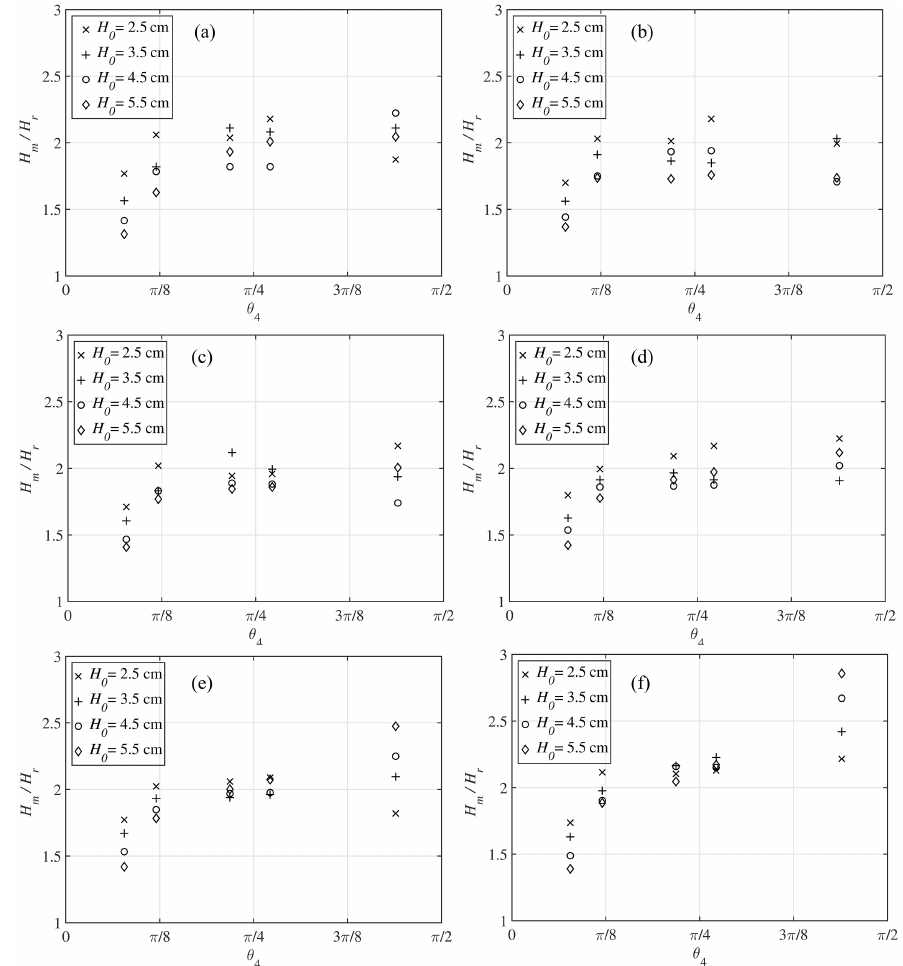
Figure 6. Wave amplification factors, H m /H r , of different cliffs: (a) x = 0.0m, (b) x = 0.06m, (c) x = 0.11m, (d) x = 0.13m, (e) x = 0.16m and (f) x = 0.21m.